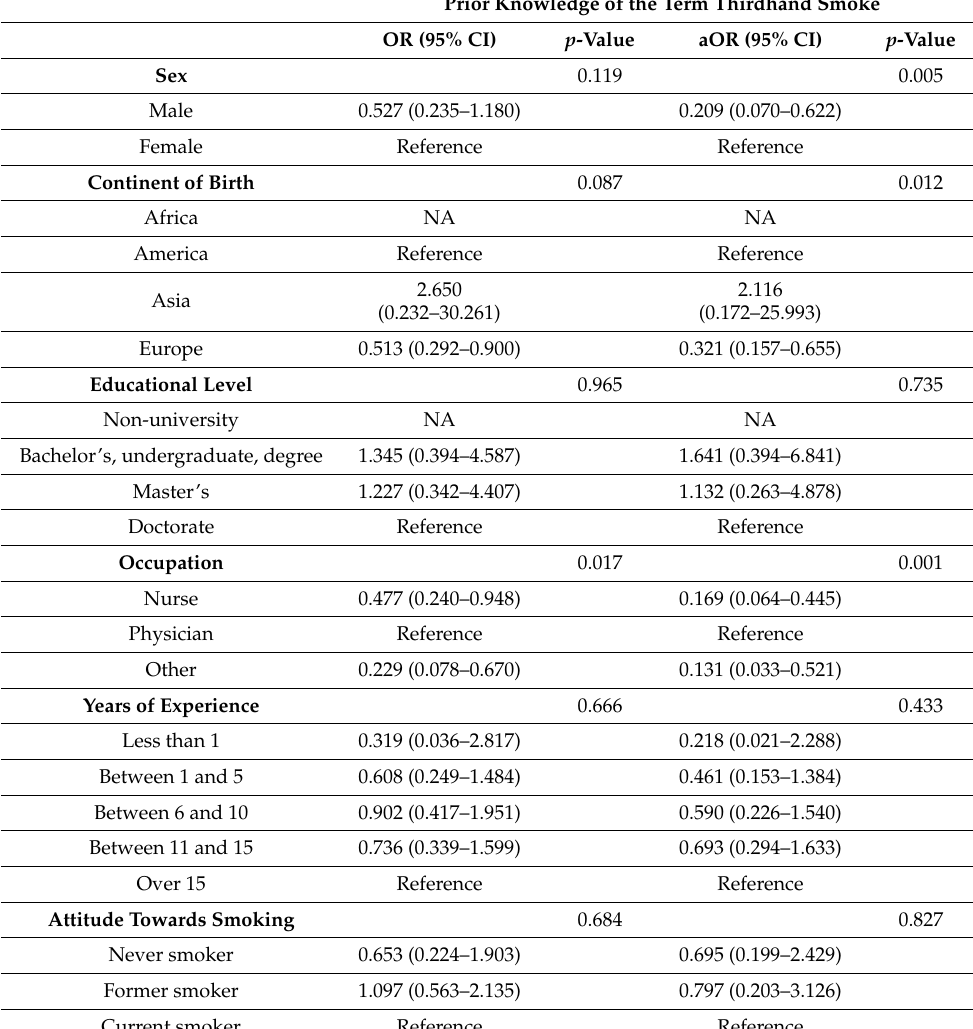
Table 4. Results of the simple and multiple logistic regression models on the variable prior knowledge of the concept thirdhand